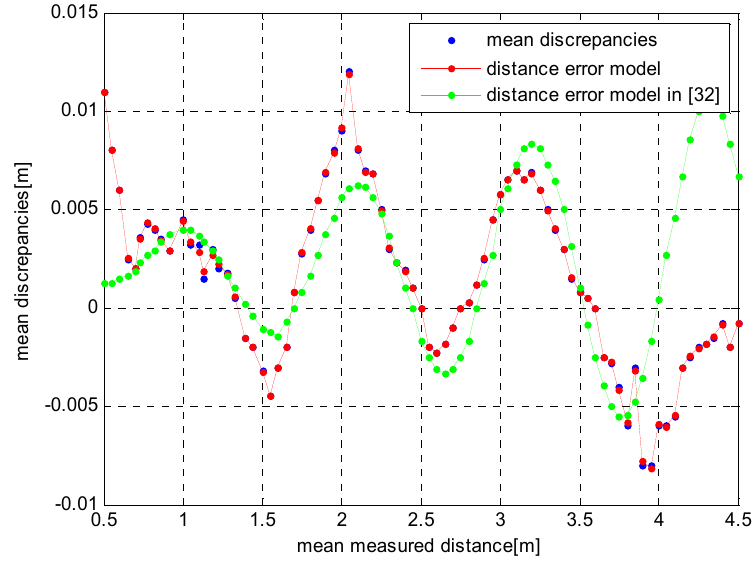
Figure 13. Depth error and error model.